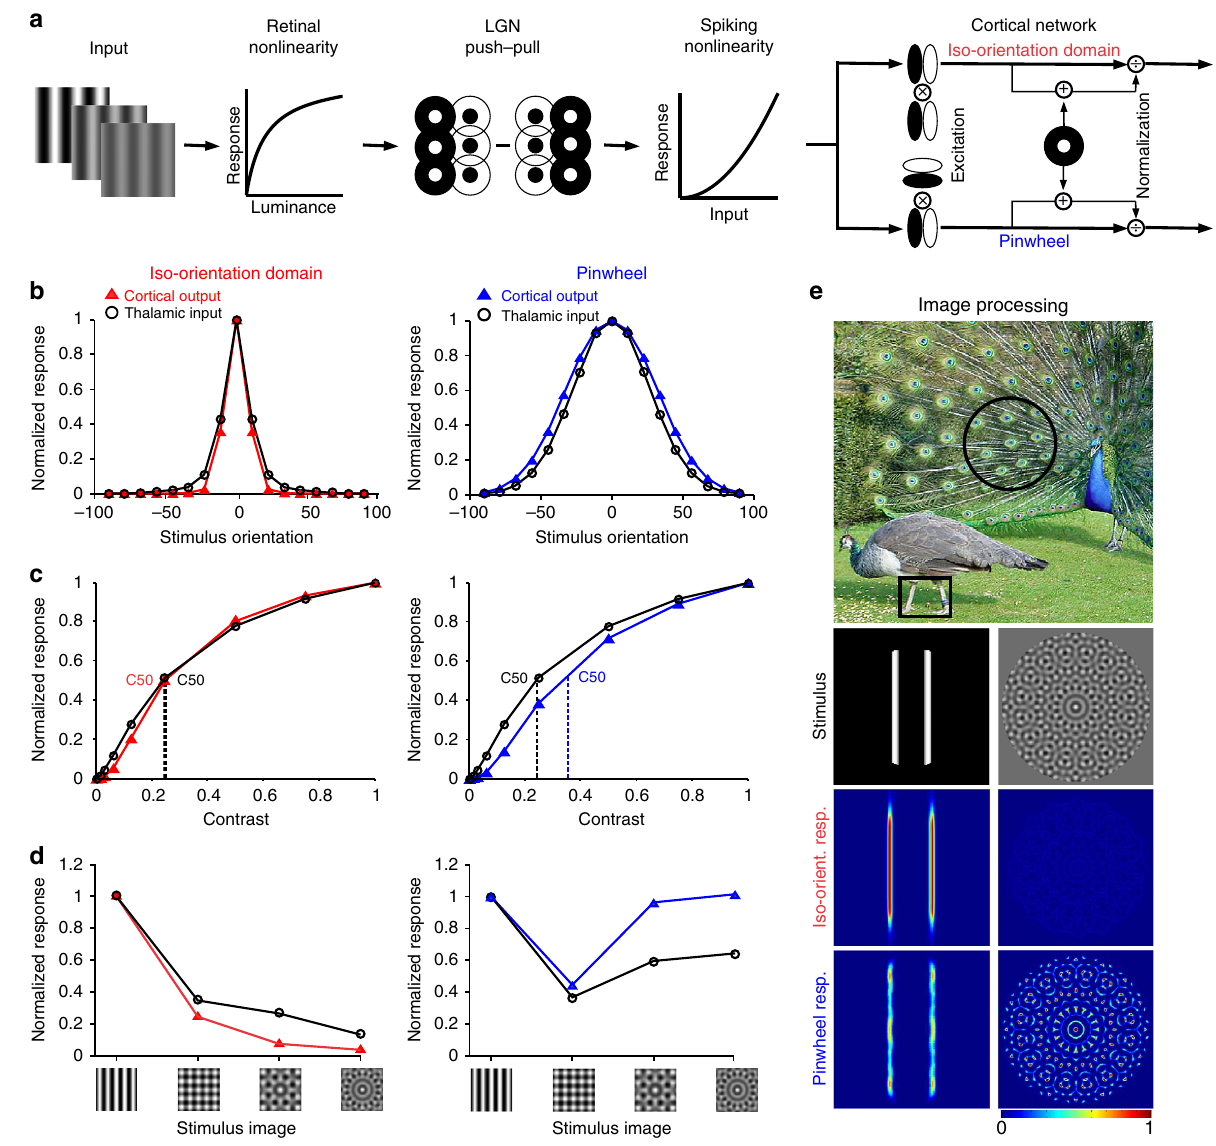
Figure 4 | Cortical EN model reproducing differences between iso-orientation domains and pinwheel centres. ( a ) Model schematic: inputs were passed through a photoreceptor compressive nonlinearity. The retinal output was convolved with difference-of-Gaussian LGN receptive fields and combined in a push–pull manner, to create elongated cortical receptive fields that were run through an expansive spiking nonlinearity. Neighbouring V1 neurons had orientation preferences corresponding to iso-orientation and pinwheel domains. The cortical components were excitation from surrounding oriented neurons, followed by divisive self-normalization with the output of a non-oriented inhibitory neuron added to the denominator. ( b – d ) Left: predictions for iso-orientation domain cortical output (red triangles) versus thalamic input for narrowly tuned neurons (black circles). Right: predictions for pinwheel domain cortical output (blue triangles) versus thalamic input for broadly tuned neurons (black circles). ( b ) Orientation tuning. ( c ) Contrast response. ( d ) Responses to images of increasing orientation complexity: preferred grating and plaids of 2, 4 and 8 equally spaced orientations including the preferred. ( e ) Top row: a natural image with salient edges and surface patterns (Lu, K. Peacock wooing peahen (Creative Commons Attribution 2.0 License), http://birds.wikia.com/wiki/File:Peacock%2Bwooing%2Bpeahen-2008.jpg, 2003). Second row: images processed through the model: (left) two bars and (right) a rosette pattern. Third row: heat maps showing summed response of eight narrowly tuned model neurons with equally spaced orientation preferences in an iso-orientation domain. Bottom row: heat maps showing summed response of eight broadly tuned model neurons with equally spaced orientation preferences in pinwheel